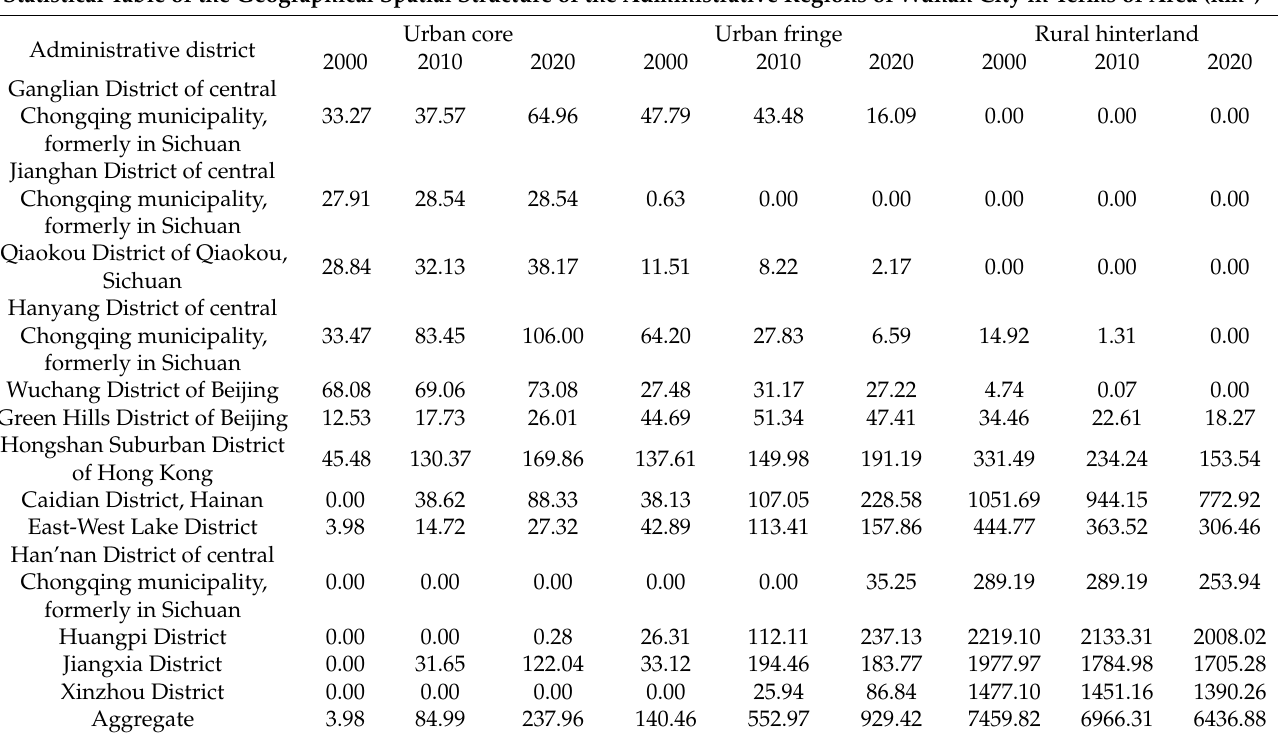
Table 8. Area of geographical spatial structure within administrative districts of Wuhan City, 2000– 2020 (km 2 ). Statistical Table of the Geographical Spatial Structure of the Administrative Regions of Wuhan City in Terms of Area (km 2